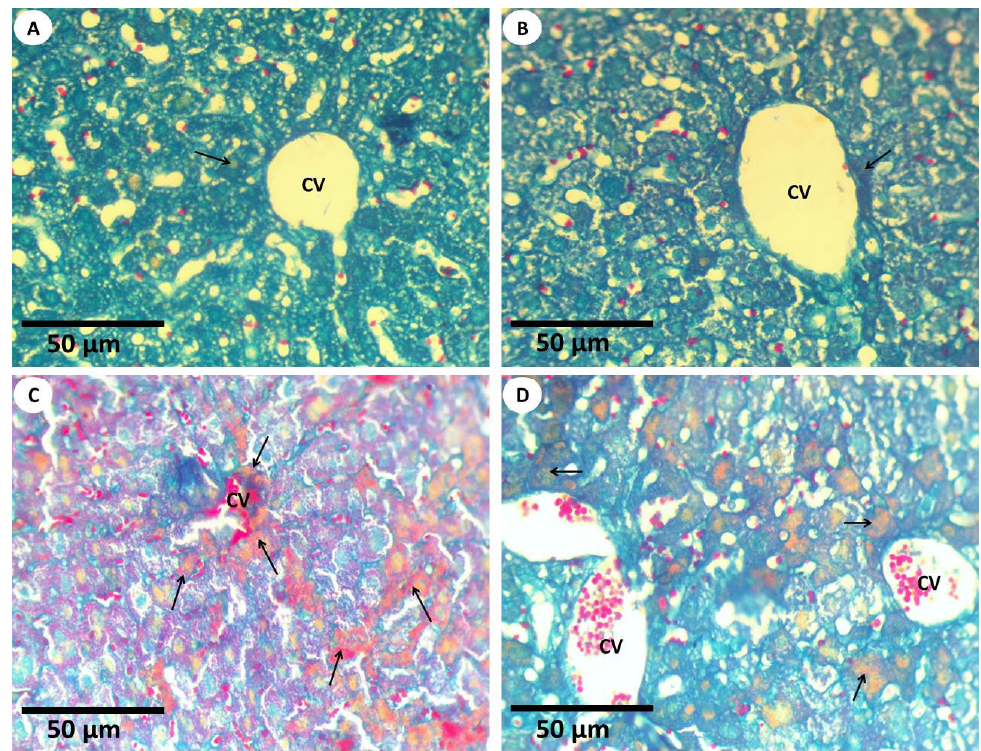
Figure 5. Light explanations microscopy for histochemistry fiber studies ( A ) Mouse liver section from the first group displaying the healthy tissues and the normal distribution of collagen and reticular fibers (arrow) in the intact liver strands around the central vein (CV) (MTS, 400×). ( B ) Mouse liver section from the second group showing the normal distribution of collagenous fibers (arrow) in the hepatic cord that was found around the central vein (CV) using Mallory trichrome stain (MTS, 400×). ( C ) Mouse liver section from the third group that displays amyloidosis and collagenous fibers (arrows) that were aggregated in the liver tissues after the mice were exposed to Fe 2 O 3 -NPs; the central vein (CV) was also engorged with blood (MTS, 400×). ( D ) Mouse liver section from the fourth group showing an improvement in the collagen fibers (arrows) within the hepatocyte, which were located around the hepatic central veins (CV) (MTS, 400×); this shows the usefulness of using PPE in the improvement of toxicity, which was induced in the morphology of the liver tissues of mice exposed to Fe 2 O 3 -NPs.